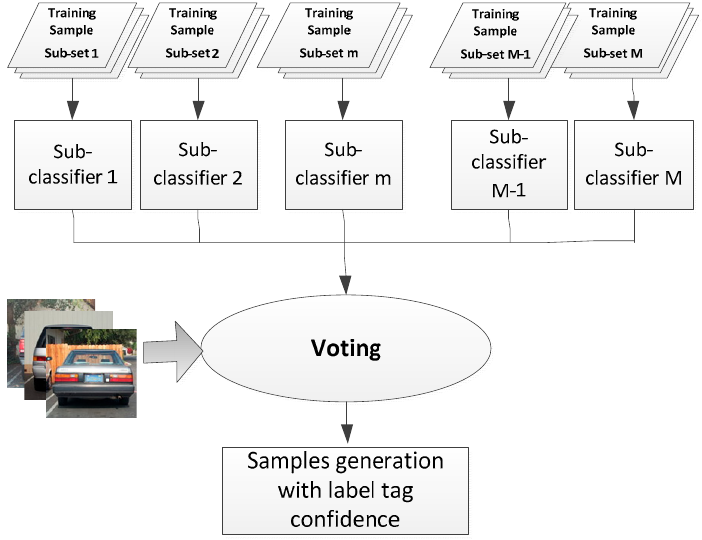
Figure 7. Sample label tag generation with confidence score.